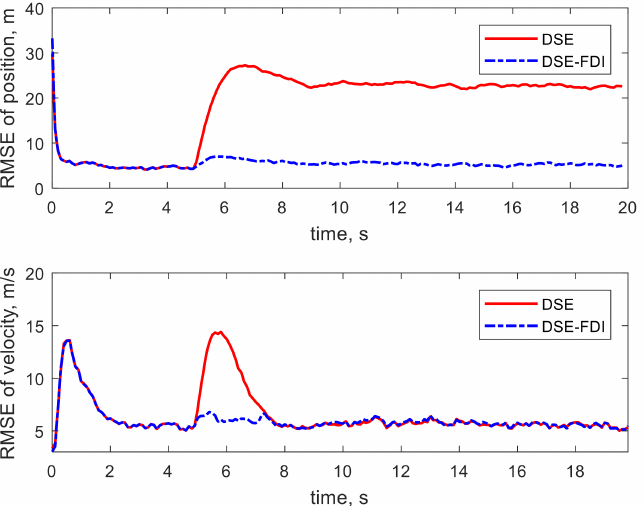
Figure 5. RMSE of the position and velocity over time for different